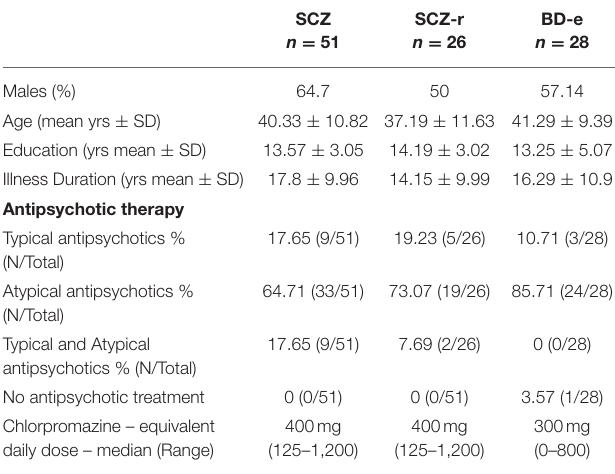
TABLE 2 | Characteristics of the study